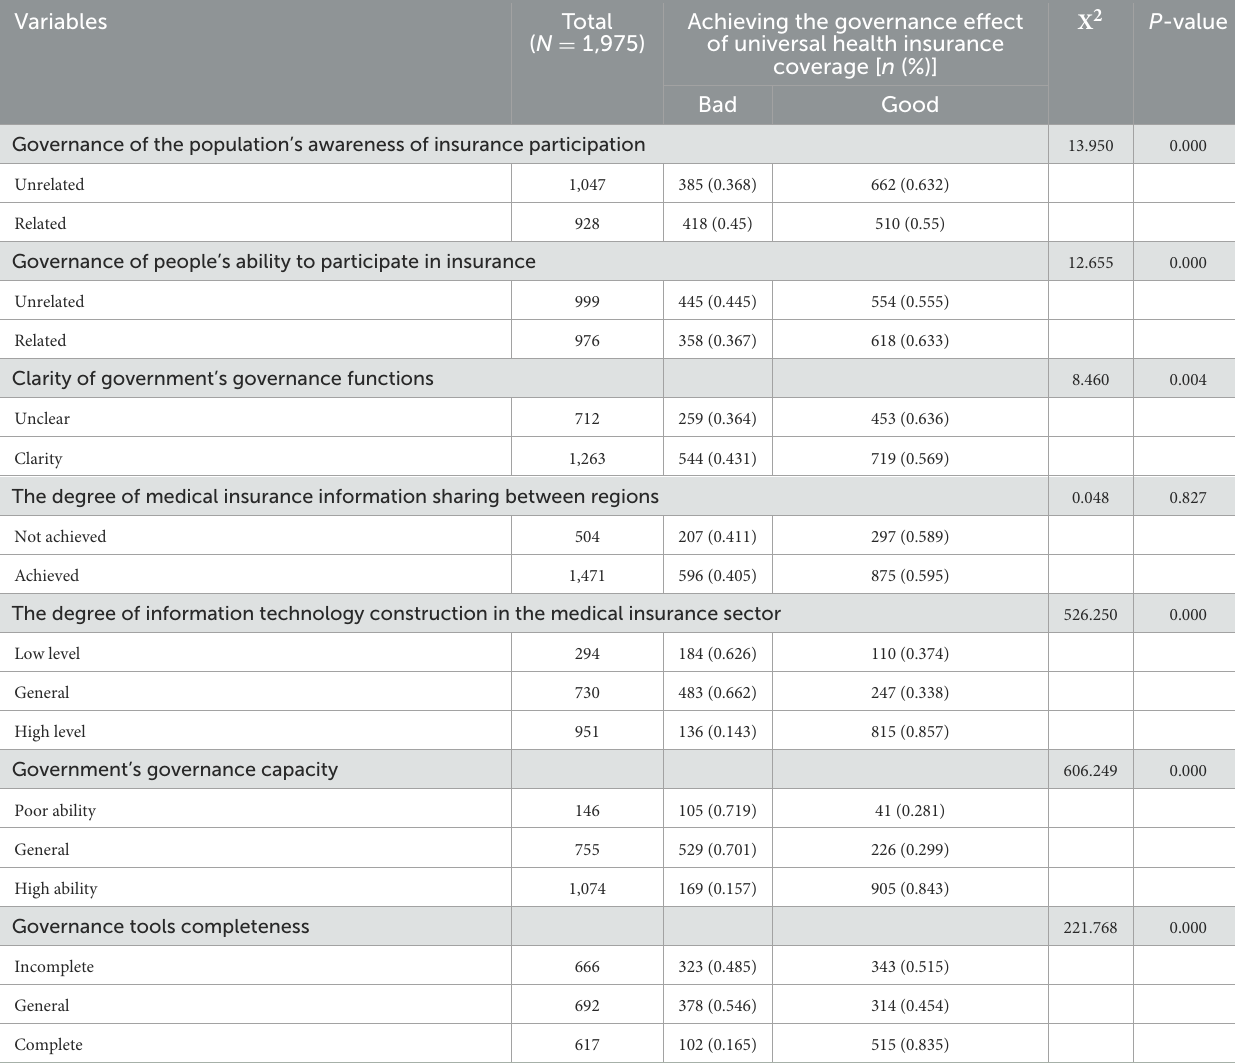
TABLE 2 Sample characteristics and univariate analysis of the effect of governance on health insurance coverage for the entire